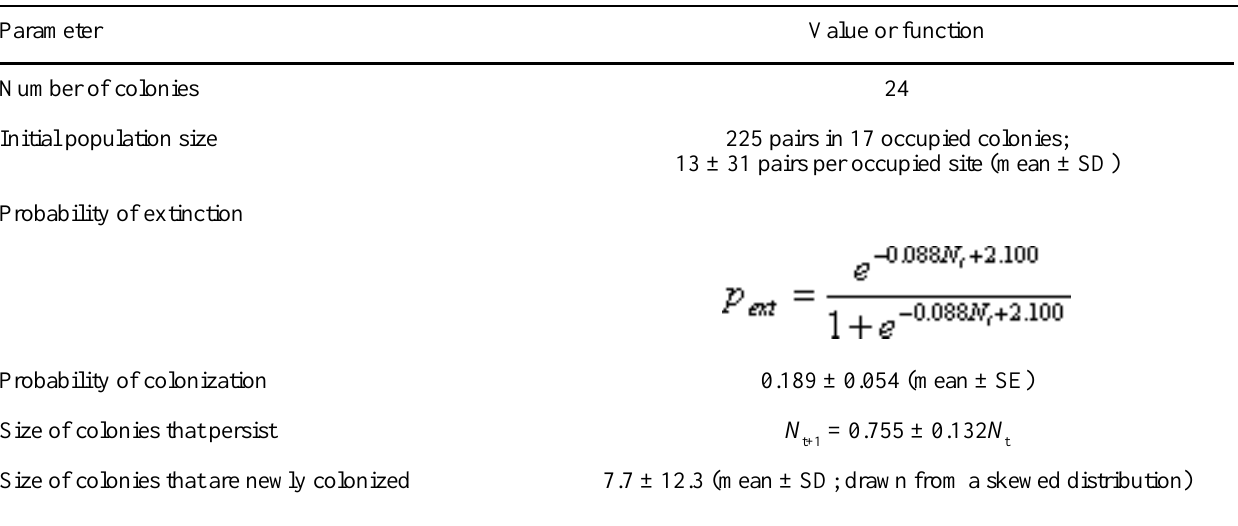
Table 1. Parameters and their values or functions used to calculate their values used in the Ivory Gull colony persistence model for Ellesmere Island and Devon